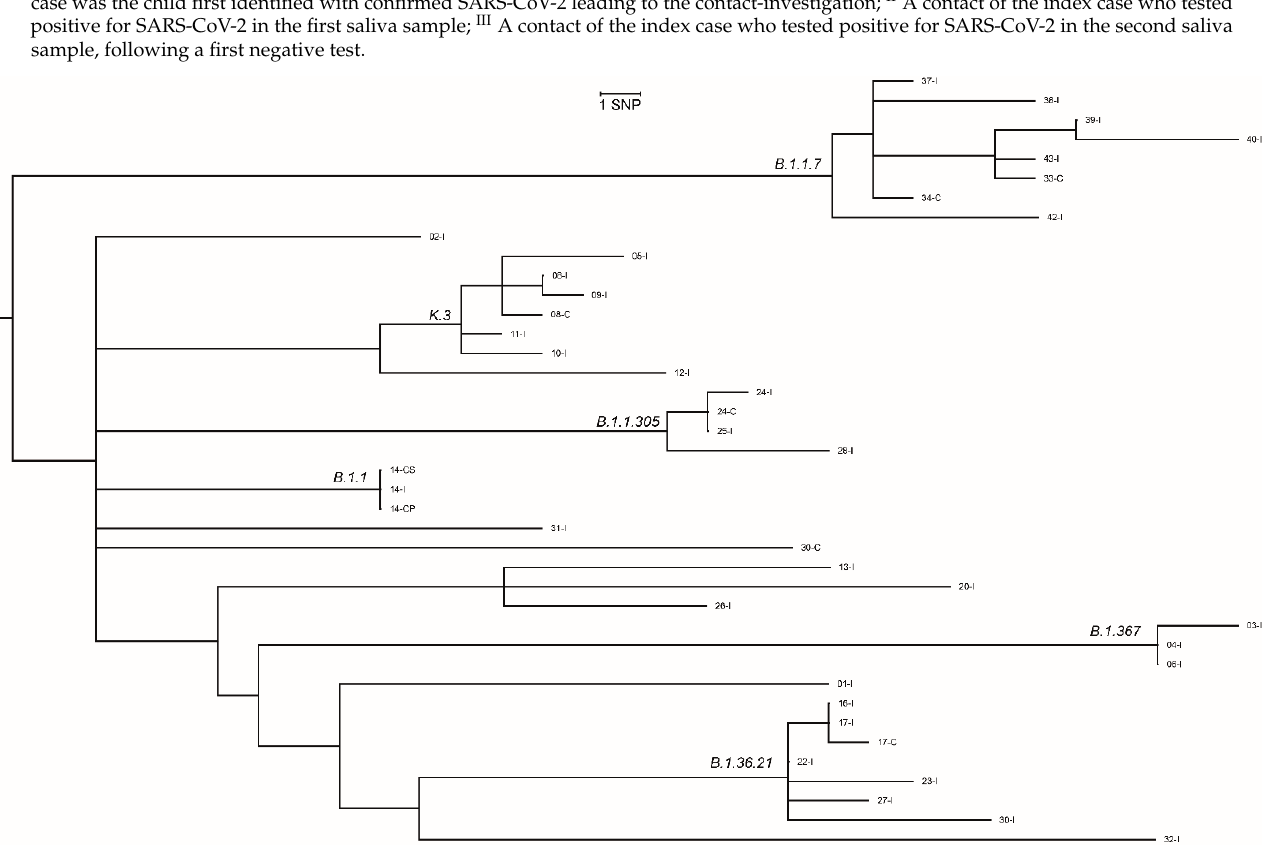
Figure 1. Maximum likelihood phylogenetic tree of SARS-CoV-2 strains from cases included in contact investigations (n, 33), Oslo and Viken, August 2020–May 2021; SNP; single nucleotide polymorphism; the whole genome sequencing